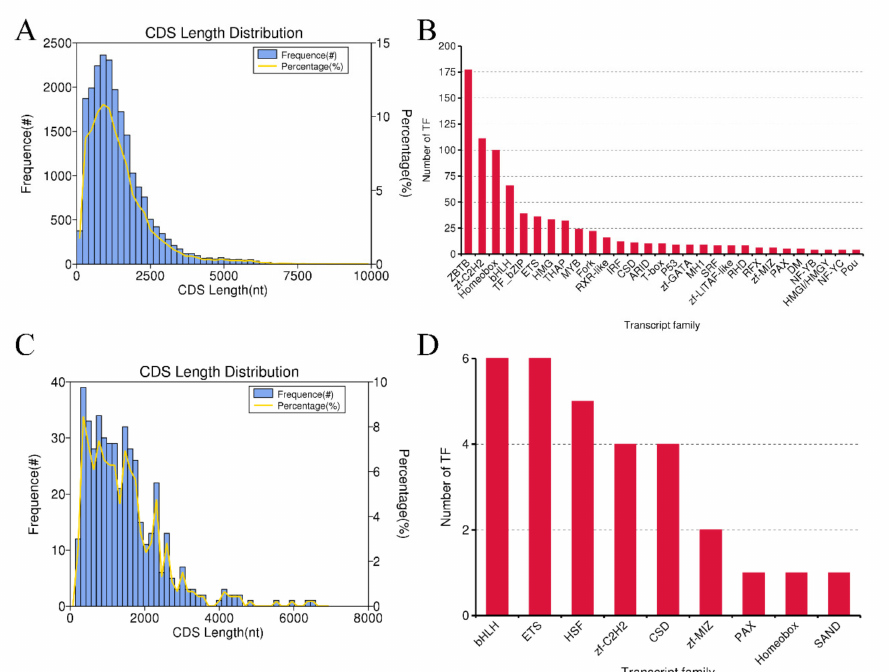
Figure 3. CDS length distribution and TF analysis in coral and zooxanthellae. ( A , C ) are CDS length distribution statistic results of coral and zooxanthellae, respectively. The horizontal axis represents the length of the predicted CDS and the vertical axis the number of CDS transcripts. ( B , D ) are the transcription factor analysis results of coral and zooxanthellae, respectively. The horizontal axis indicates different transcription factor families and the vertical axis the TF